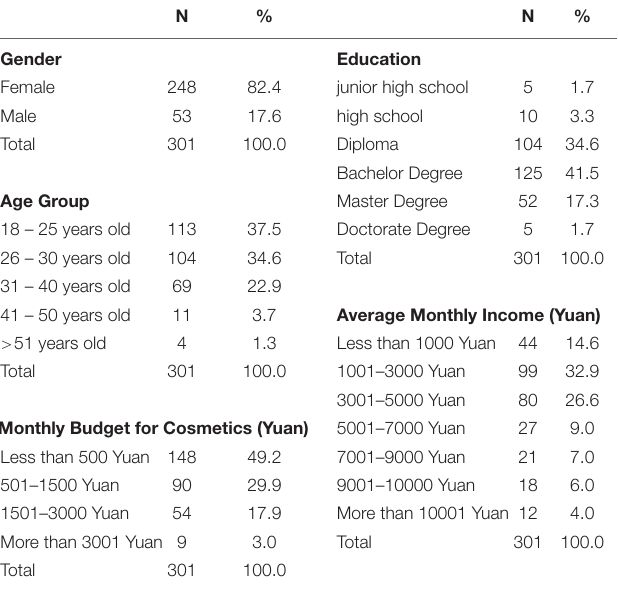
TABLE 2 | Demographic characteristics.